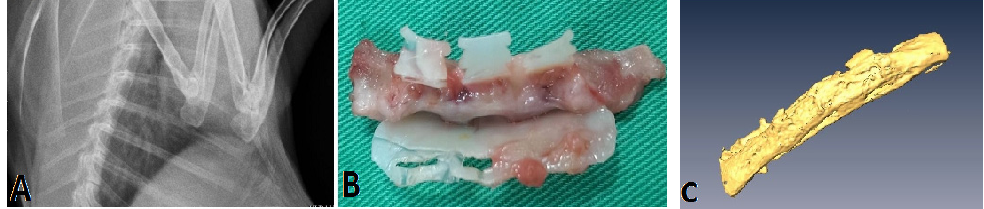
Figure 5. Results after the osteosynthesis surgery for the rib osteomized by PCL fixator. ( A ) The osteomized rib showed union on the 12 ‐ week follow ‐ up X ‐ ray; ( B ) The specimen showed the osteomized rib with good callus formation grossly; ( C ) Three ‐ dimensional CT reconstruction showed good rib cortex continuity and callus formation.